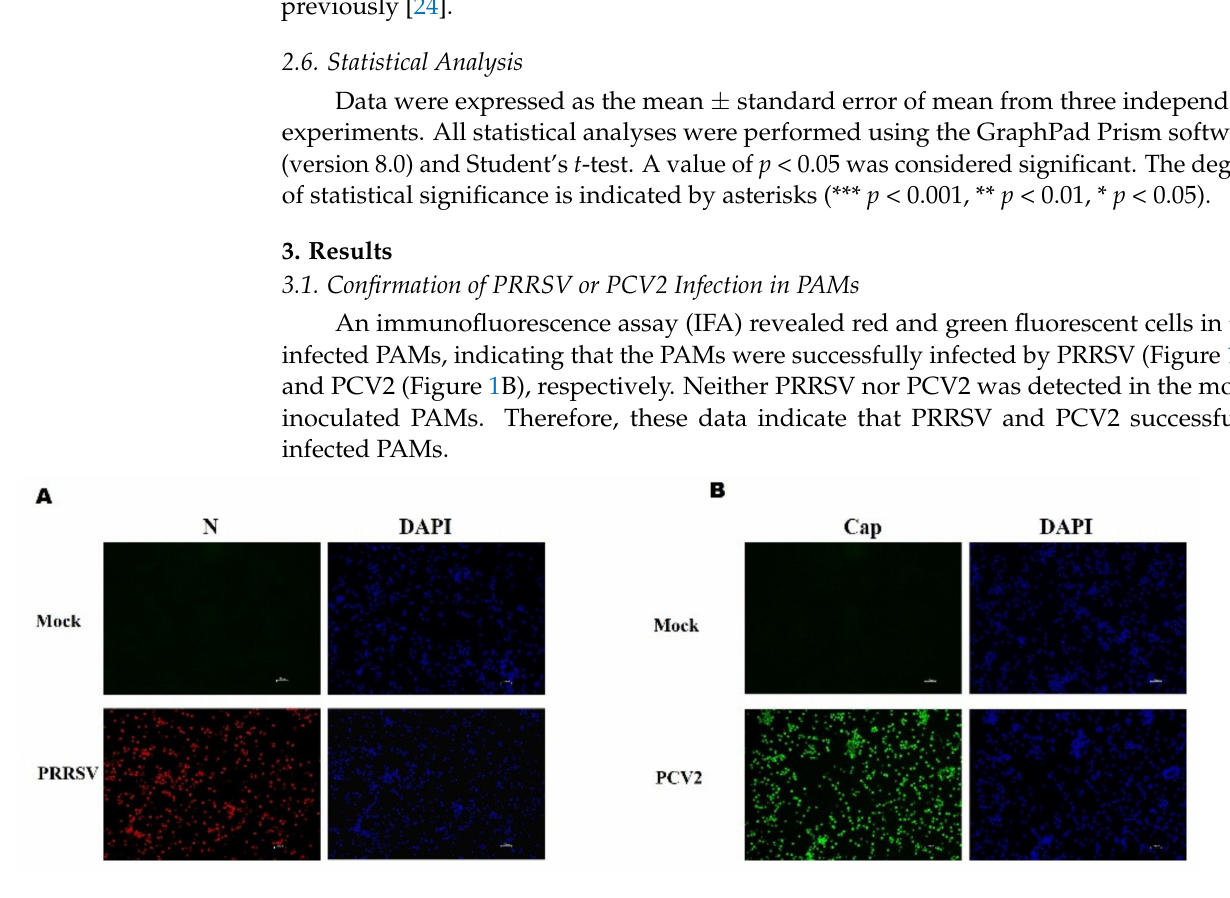
Figure 1. Immunofluorescence antibody staining for virus-infected PAMs by IFA. ( A ) Mock- inoculated and PRRSV-infected PAMs were stained with PRRSV N protein (red)-specific monoclonal antibody. ( B ) Mock-inoculated and PCV2-infected PAMs were stained with PCV2 Cap protein (green)-specific monoclonal antibody. Magnification: ×